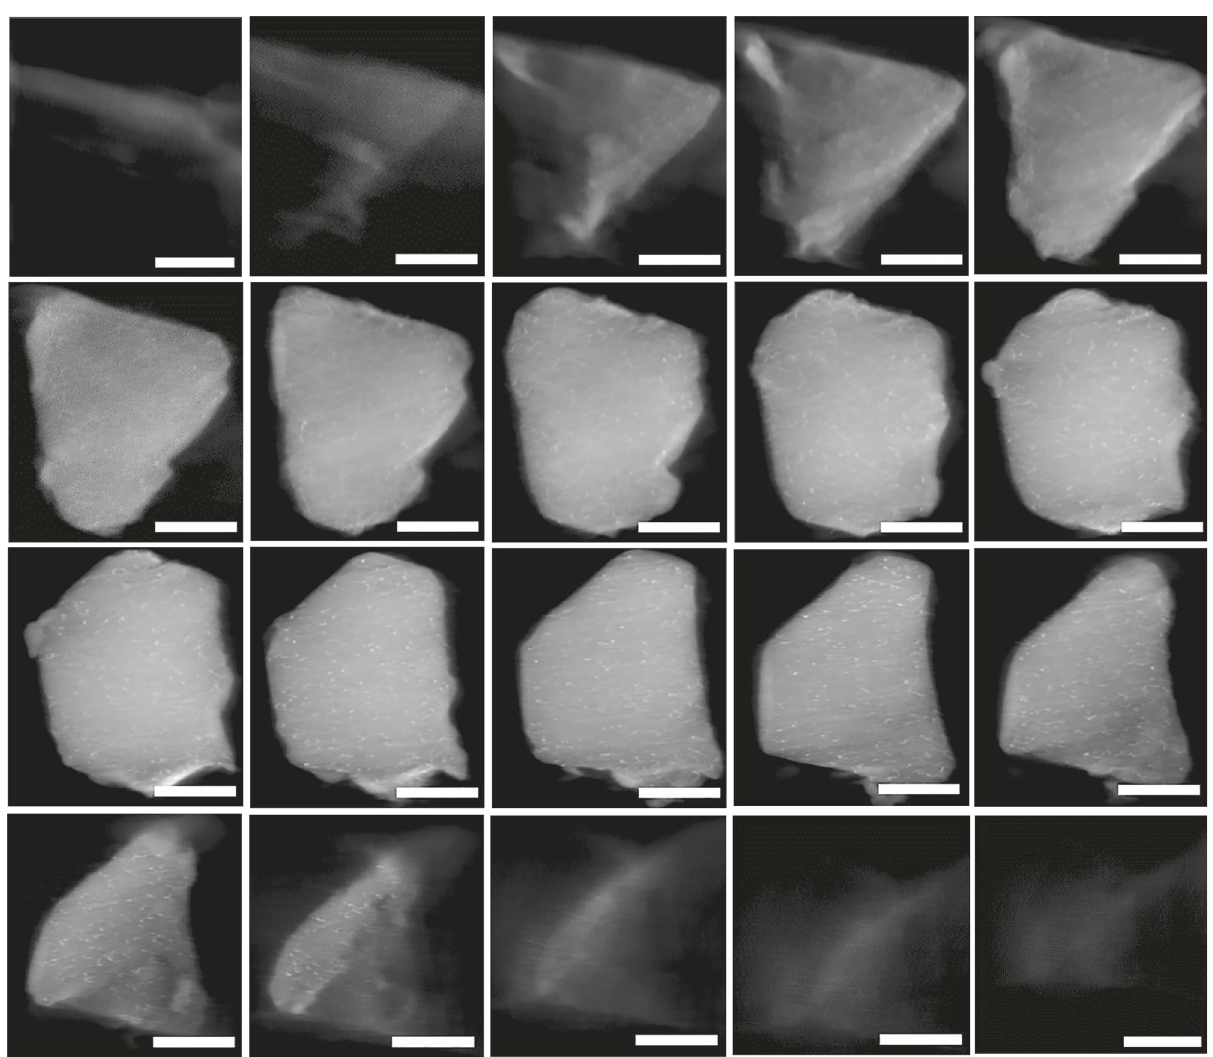
Fig. 3 Reconstructed slice images. Selected reconstructed slice images (observed in the order of left to right and top to down) throughout the entire Pt 1 Cu 2 @MIL-101 skeleton. The scale bar on the images is roughly ~200